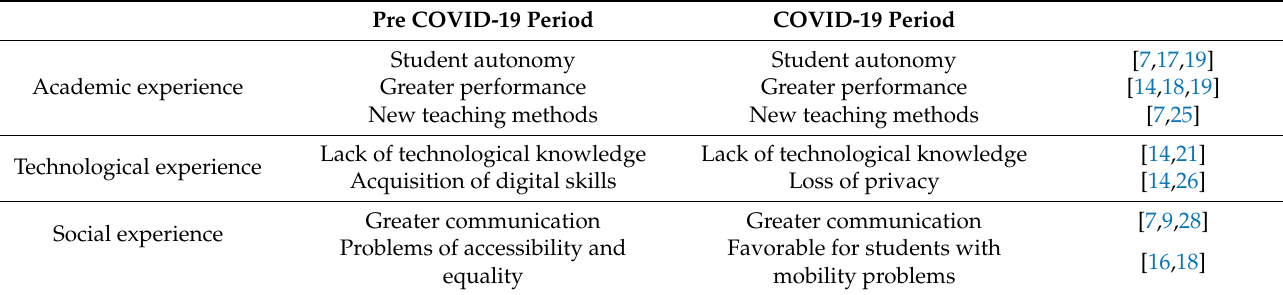
Table 1. Summary of the main results for each period